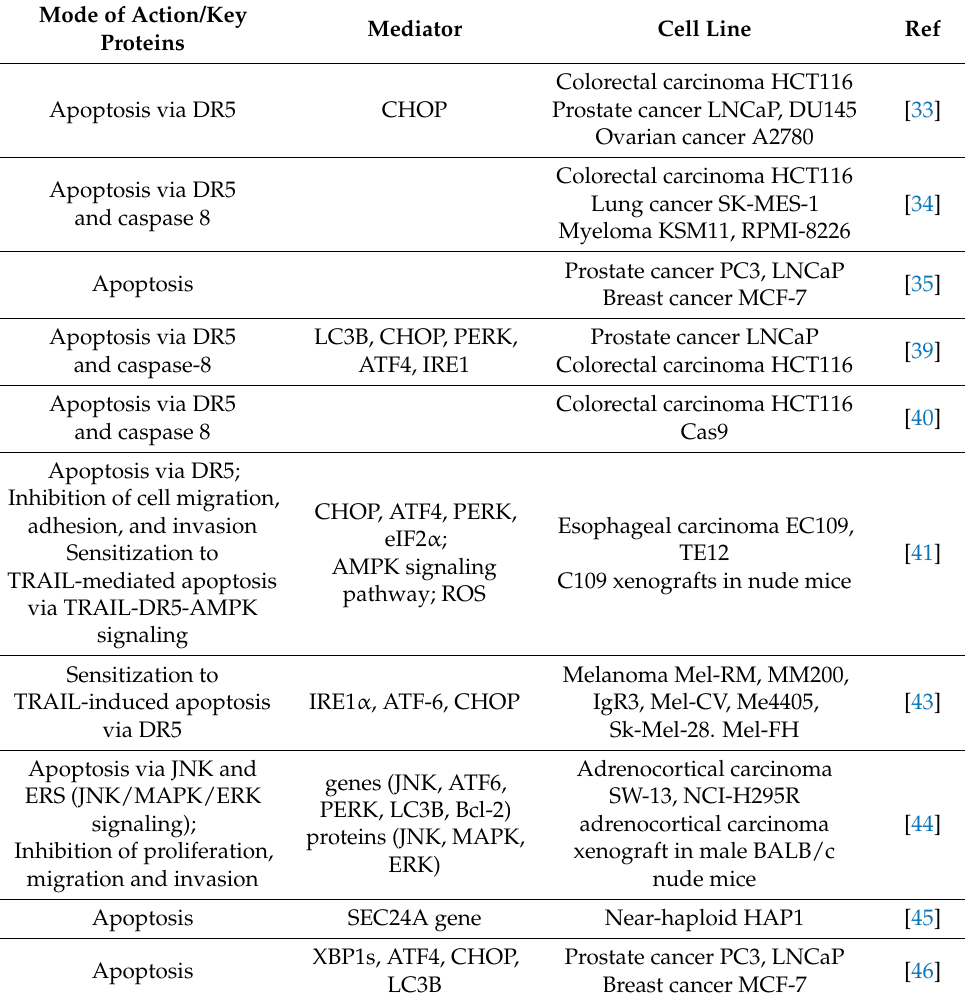
Table 1. Cell death mode and key mediators involved in Tg action in various cancer cell